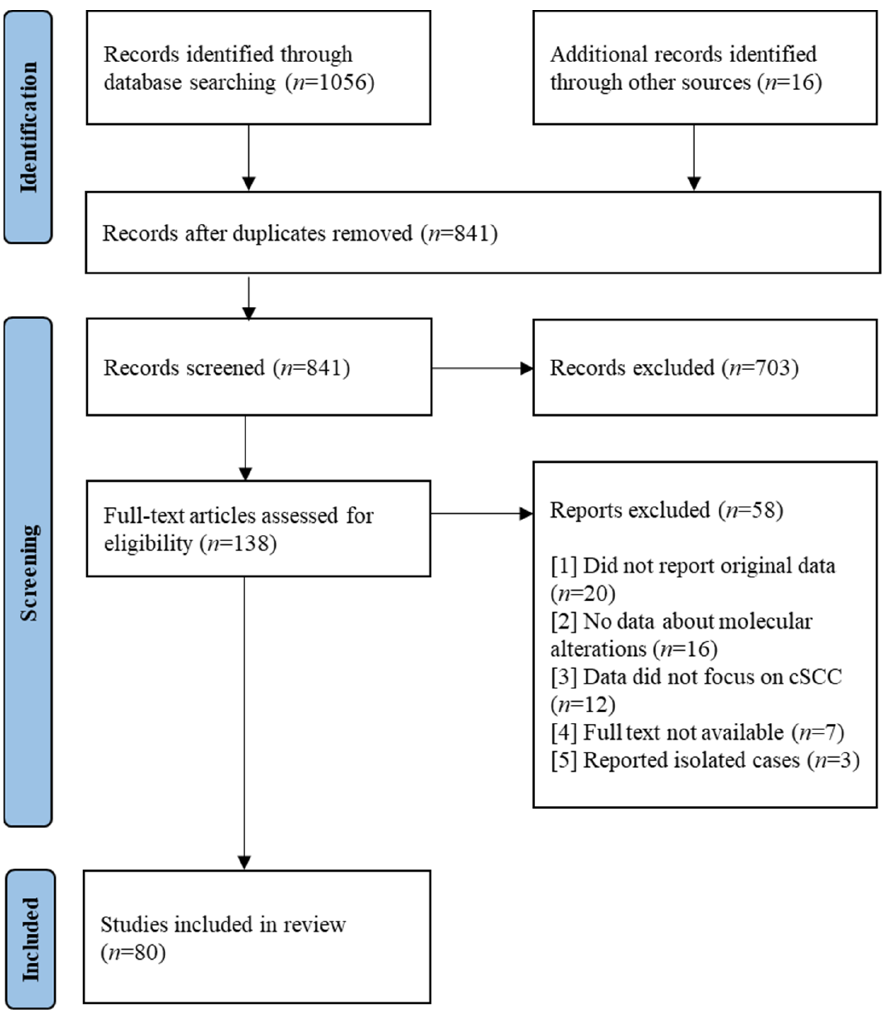
Figure 1. PRISMA 2020 flow diagram.